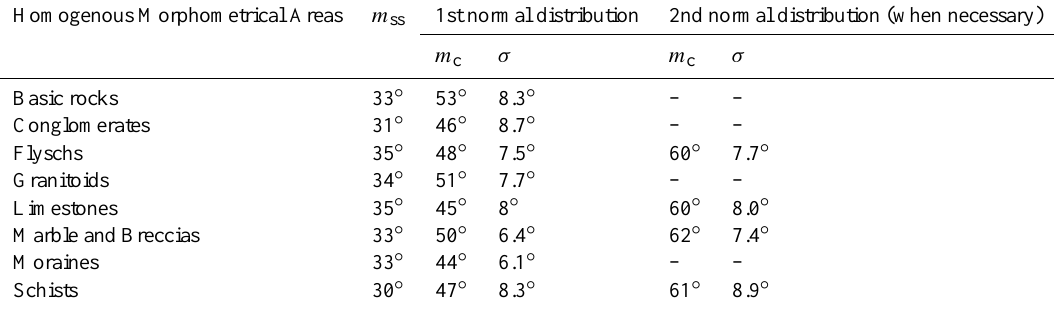
Table 2. Slope angles extracted from SAD analysis of each HMA. According to Fig. 2a and 3a, mean values and standard deviations of cliffs distributions correspond respectively to letters m c and σ , and mean values of the steep slopes to letters m ss . Homogenous Morphometrical Areas m ss 1st normal distribution 2nd normal distribution (when necessary) m c σ Basic rocks